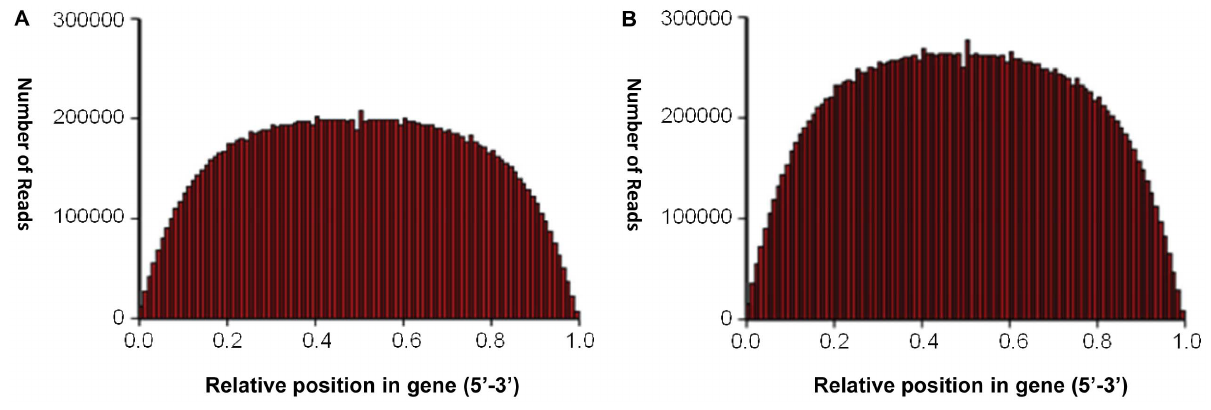
Figure 2. Random distributions of reads on unigenes. The analysis of random distribution of reads on unigenes from: A, cotyledon and B, embryo axis, respectively.